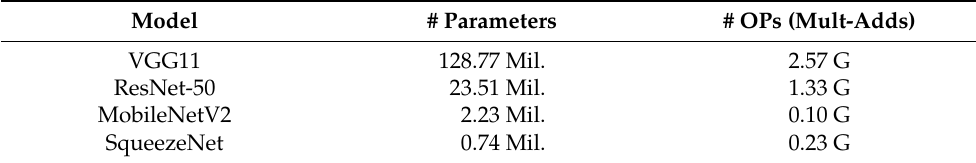
Table 1. Number of parameters and number of operations for the four models of the study.